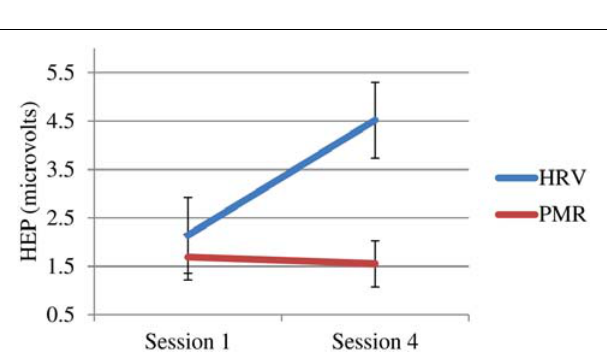
FIGURE 4 | Heartbeat event related potential (HEP) at 250 μ s for both groups pre vs. post-training (sign